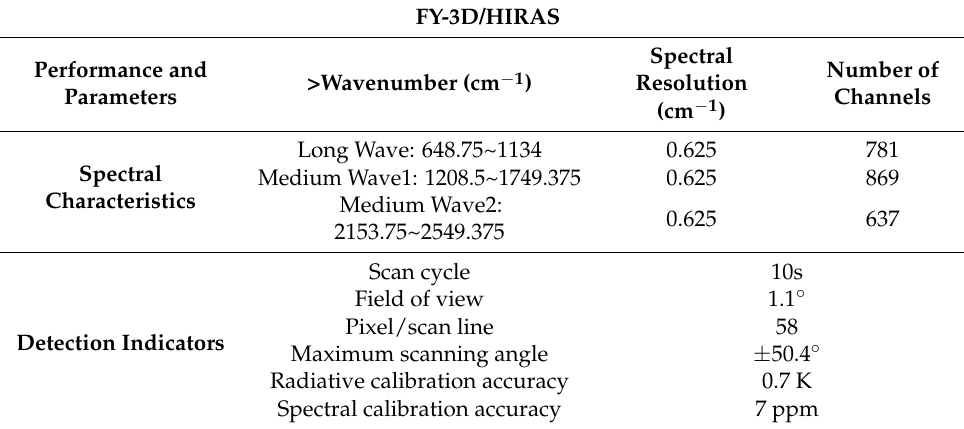
Table 1. FY-3D/HIRAS spectral characteristics and detection